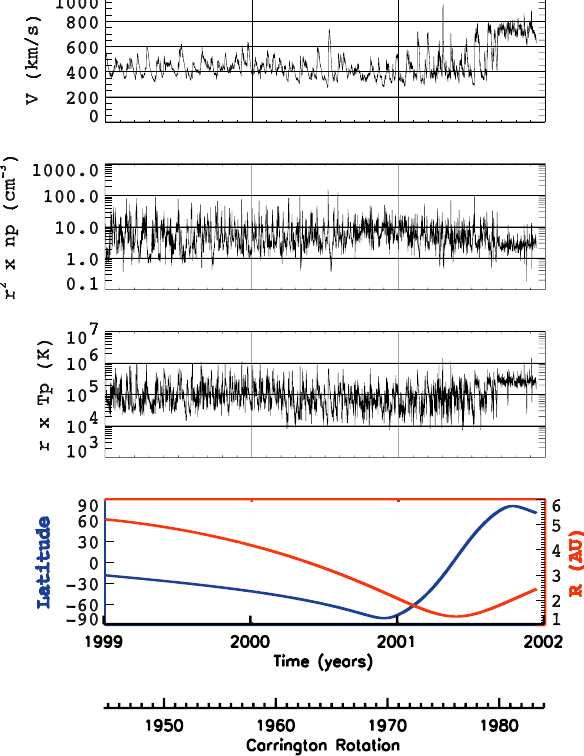
Fig. 1. Ulysses measurements (1-h averages) of solar wind speed, density, and temperature, together with the spacecraft’s location (ra- dial distance: red, and heliographic latitude: blue) from 12 January 1999 to 19 September